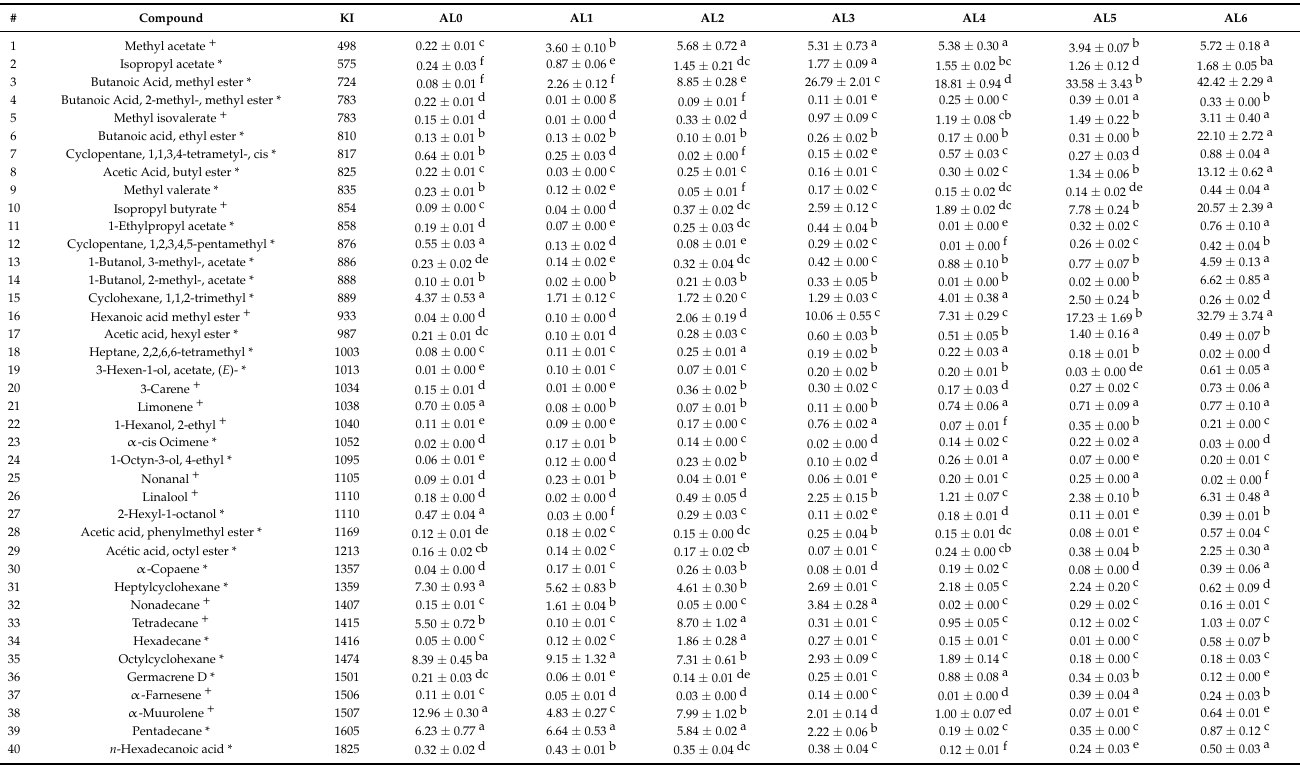
Table 1. Volatile organic compounds related to aroma in Albion variety strawberries at seven stages of